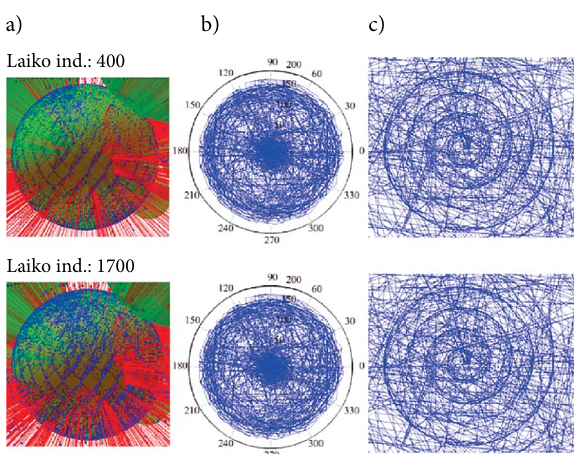
Fig. 9. Formation of fields of the i th particle’s velocity vectors and their normal planes in the polydispersed mixture: a – texture formed at particular time on the surface of the particle of the intersection between normal planes of velocity vectors; b – change of the velocity vector direction in the polar coordinate system c – the central part of the chart.